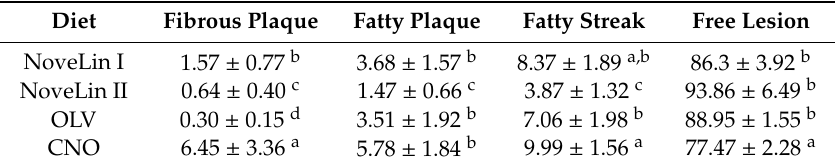
Table 6. Percentage of fibrous plaques, fatty plaques, fatty streaks and lesion free areas in the aorta of rabbits fed intervention